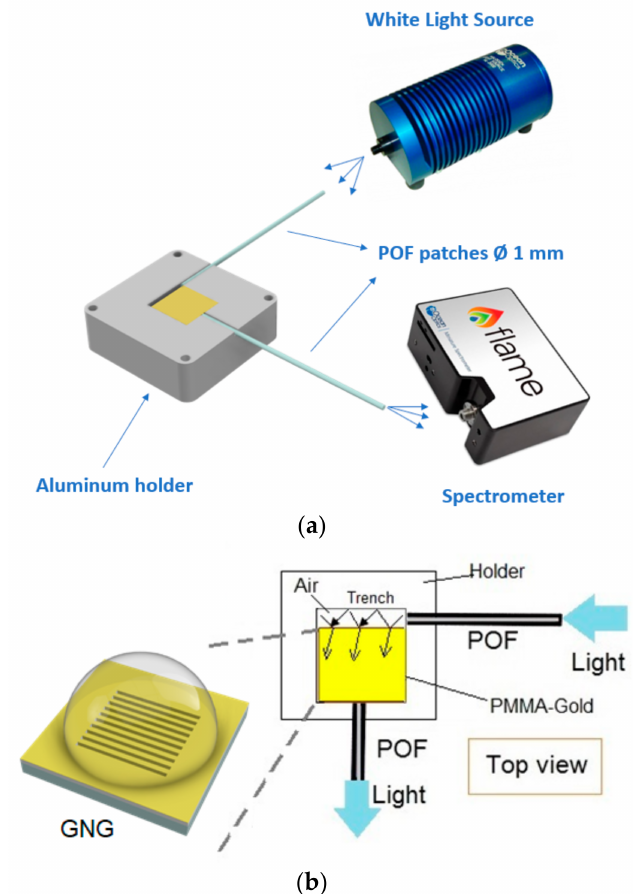
Figure 2. ( a ) Outline of the experimental setup. ( b ) Light propagation path through the setup.